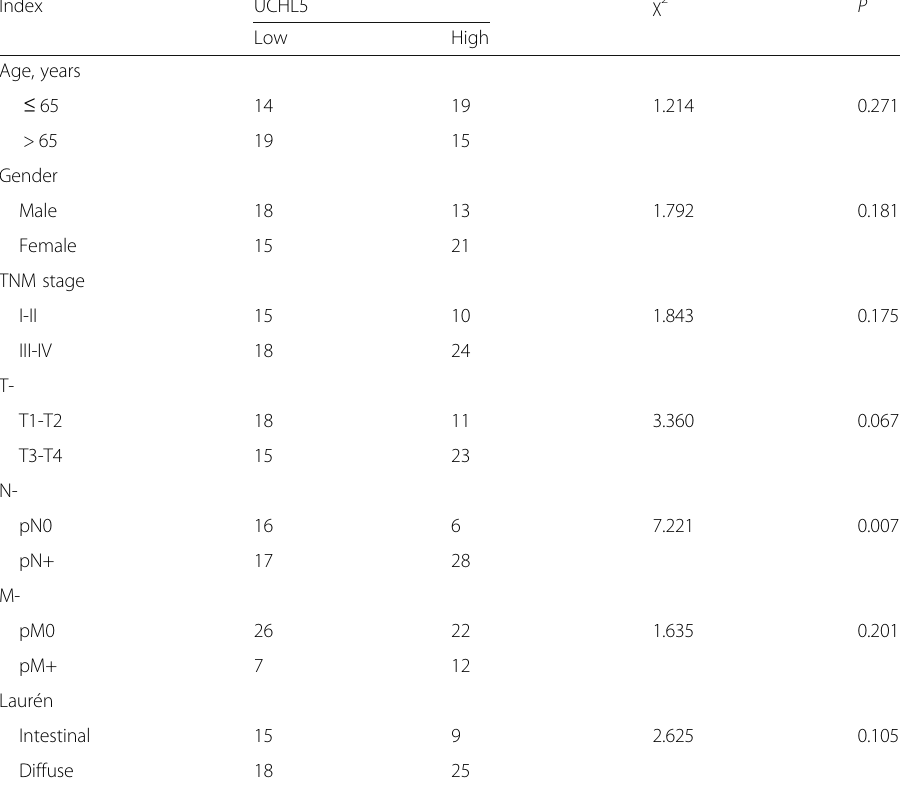
Table 2 Association of UCHL5 with clinicopathological variables in GC